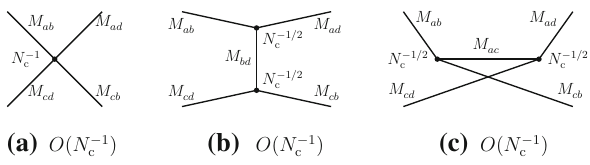
Fig. 3 The diagrams of Fig. 2 in unfolded form